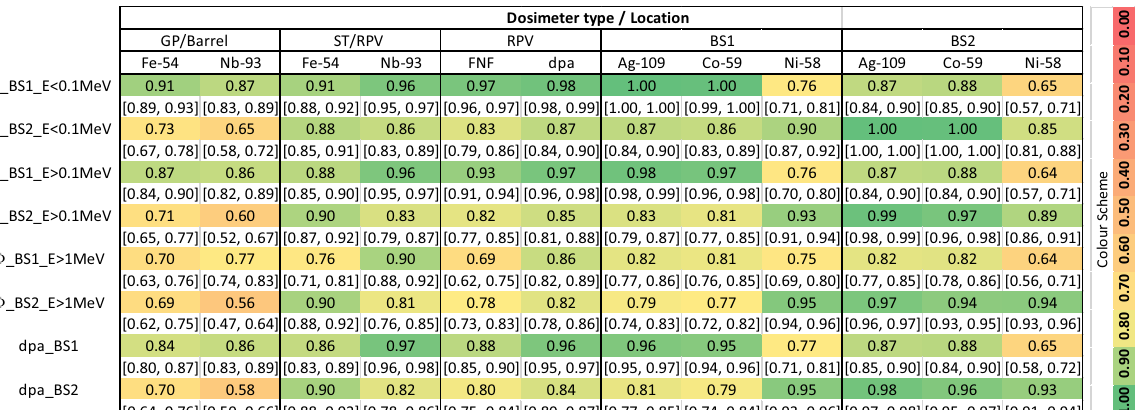
Table II. ND-related Pearson correlation coefficients obtained for the considered models and parameters